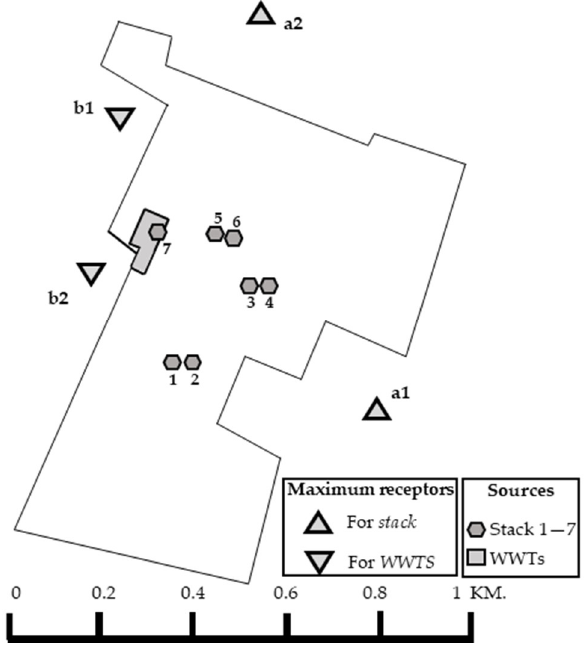
Figure 4. Maximum ground-level concentration at discrete receptors for different source types (a1–a2 were the maximum receptors for stack sources and b1–b2 were the maximum receptors for WWTs source).